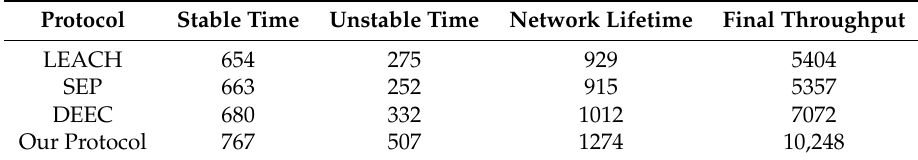
Table 4. A performance comparison between the four clustering protocols in the homogeneous networks (initial energy = 0.4 J).